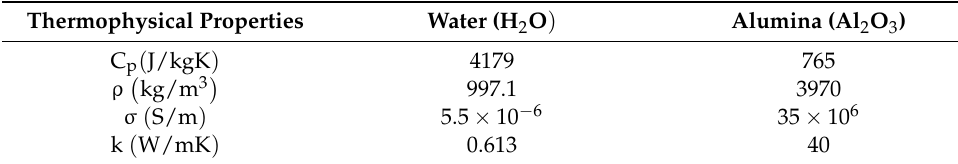
Table 1. Thermal properties of water and alumina (Al 2 O 3 )